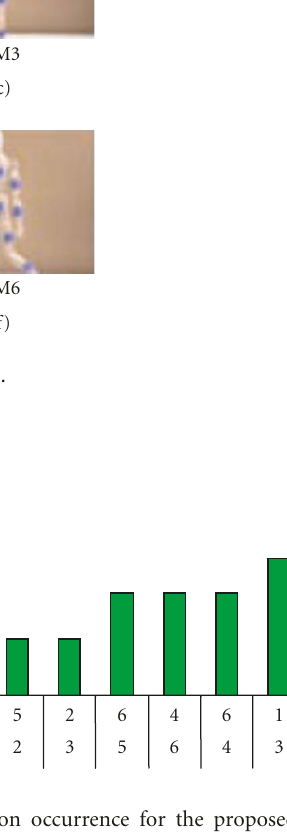
Figure 10: Confusion occurrence for the proposed incremental SVM.